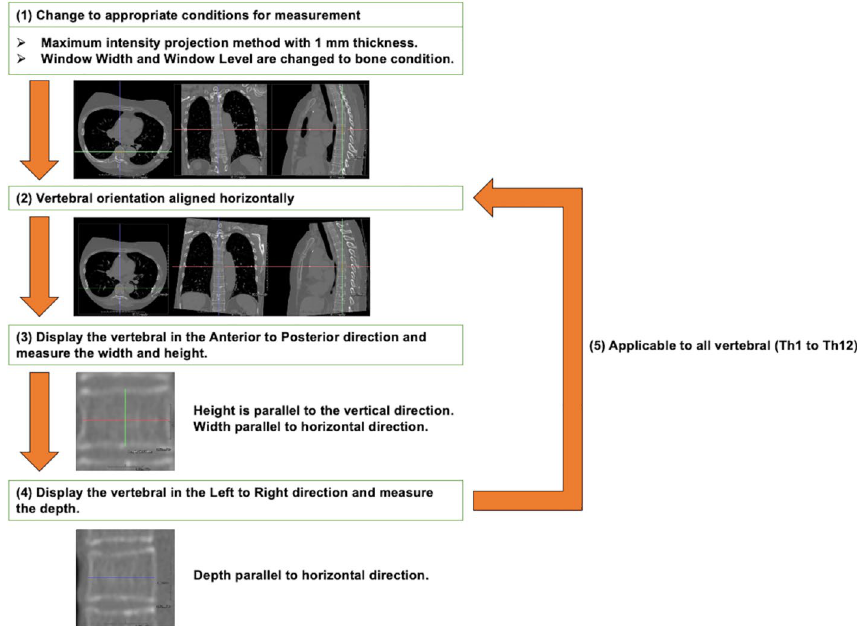
Figure 7. Overview of measurement method for thoracic vertebral